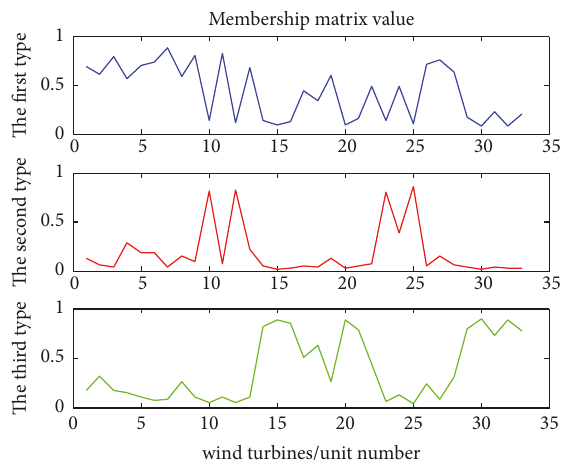
Figure 5: Membership matrix value curves of three types of units.